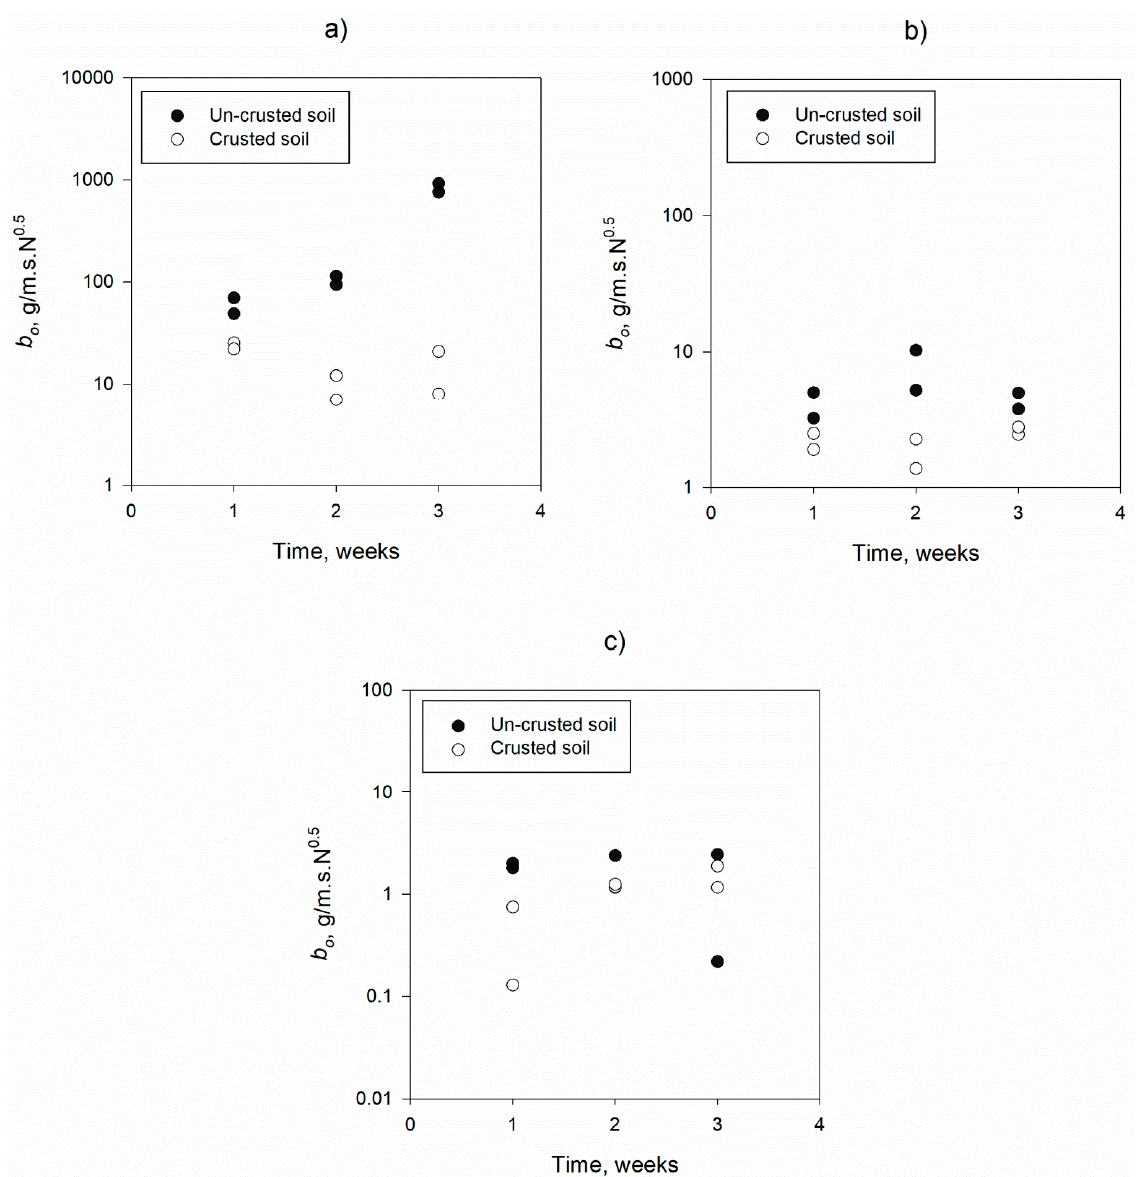
Figure 3. The influence of three different curing times of 1 week, 2 weeks, and 3 weeks on the dimensional soil detachment parameter ( b 0 ) of the Wilson model derived from the JET instrument achieved on soil specimens of crusted and uncrusted soils in the presence of different humic acid concentrations: ( a ) 0% (no humic acid), ( b ) 4%, and ( c ) 8%. Note that each test was replicated.